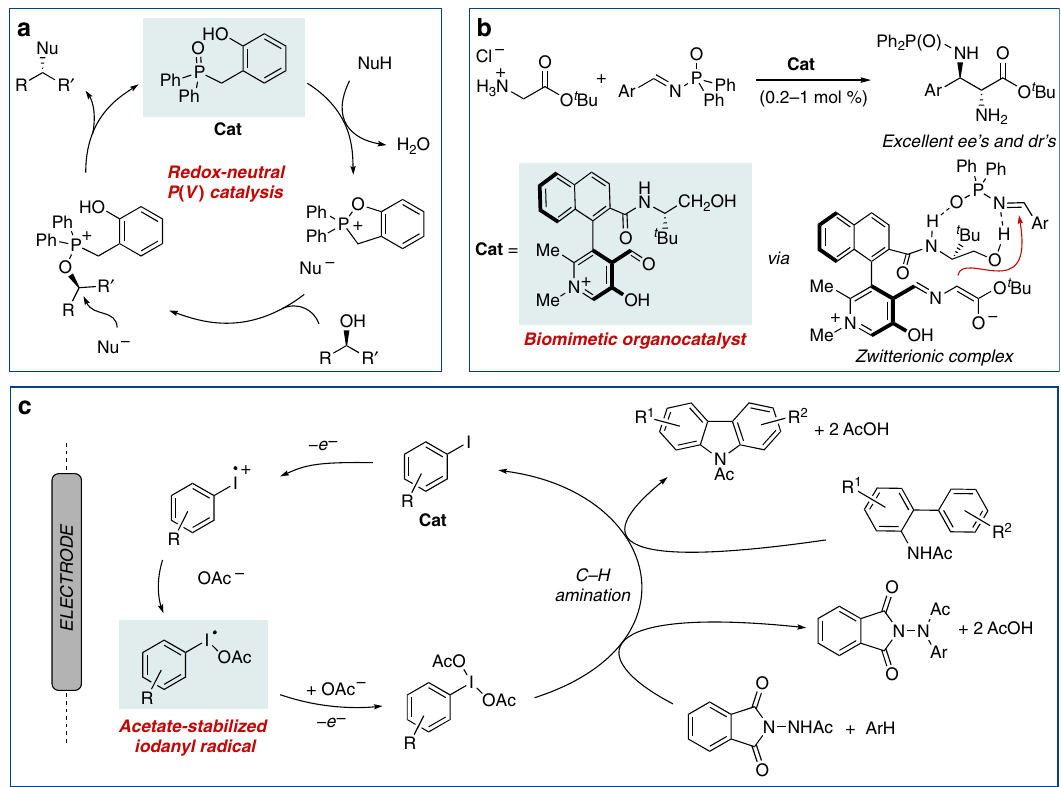
Fig. 1 Selected innovative strategies in organocatalysis. a Proposed redox-neutral catalytic cycle for the Mitsunobu reaction. Nu nucleophile. b Biomimetic approach for Mannich reaction of free glycinates using an axially chiral pyridoxal catalyst. c Electroorganocatalytic C – H amination of arenes mediated by hypervalent